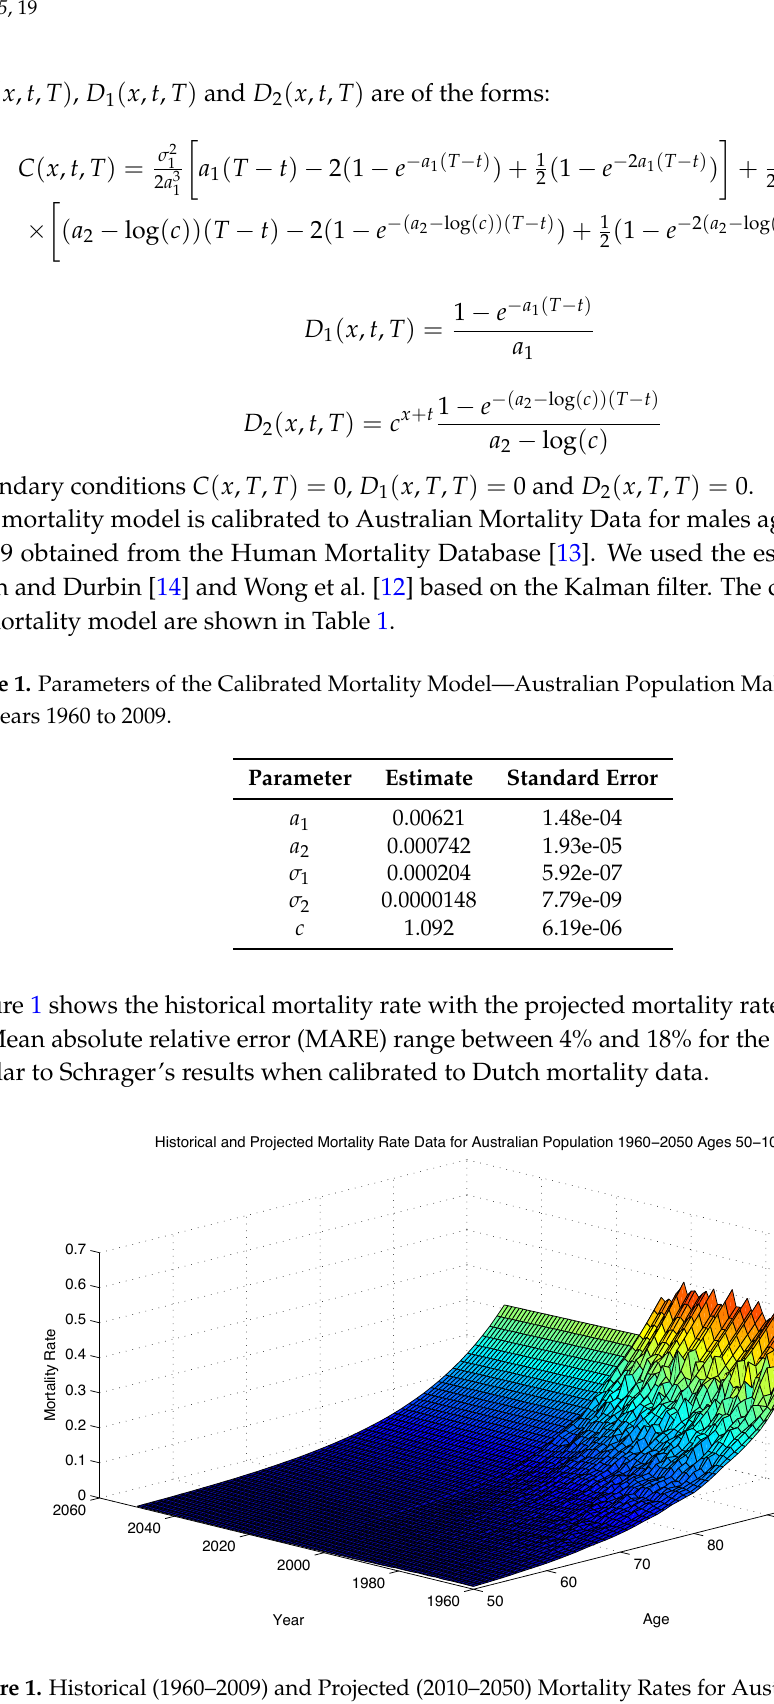
Figure 1. Historical (1960–2009) and Projected (2010–2050) Mortality Rates for Australian Population Males Aged